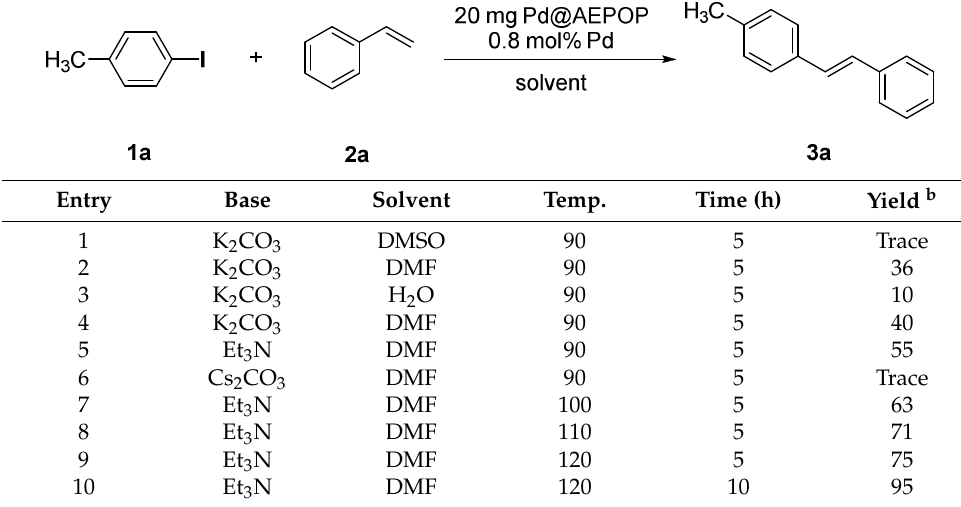
Figure 3. PXRD patterns of AEPOP and Pd@AEPOP. Table 1. Identification of reaction conditions a .